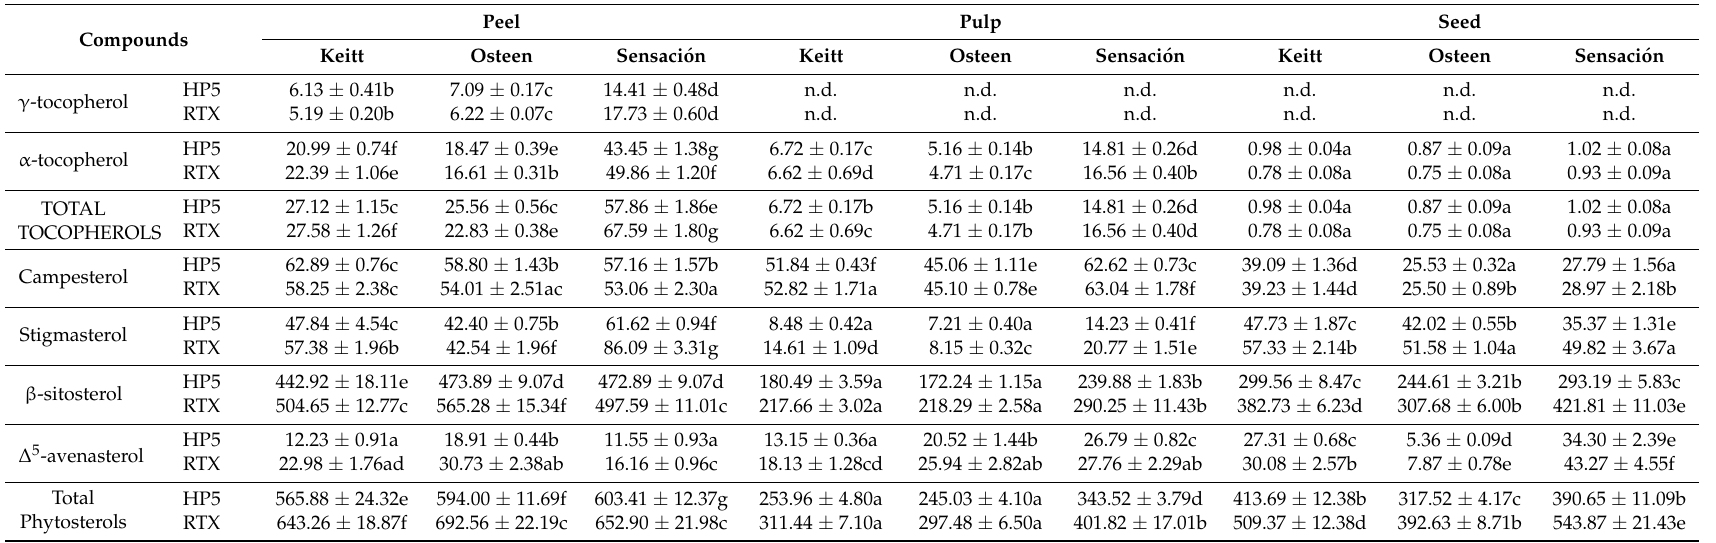
Table 4. Phytosterols and tocopherols quantification in mango pulp, peel and seed of “Keitt”, “Osteen”, and “Sensaci ó n” cultivars measured with HP5 and RTX columns by GC-QTOF-MS expressed as µ g/g dry